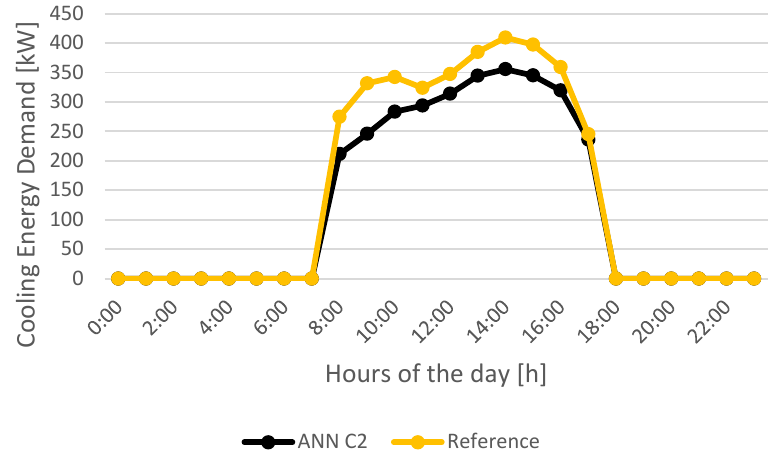
Figure 7. Daily load profile (13 September) comparison between ANN model C2 and reference for the cooling period.